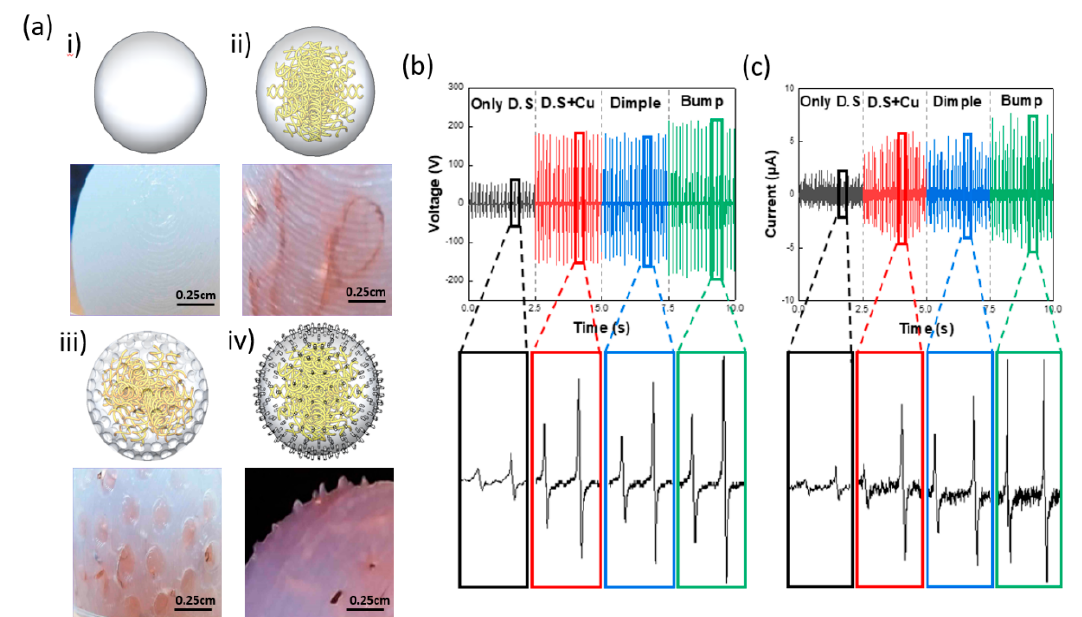
Figure 4. Changes in the output values according to the shape of the silicone rubber ball. ( a ) Pictorial representation and photographs of silicone rubber ball shapes: (i) the modeled shape and a 4× magnification photograph of the silicone rubber surface of the ball made only of D.S., (ii) the modeled shape and a 4× magnification photograph of the silicone rubber surface of the ball made by mixing copper wool into the silicone rubber ball interior, (iii) the modeled shape and a 4× magnification photograph of the silicone rubber surface of the ball made by adding dimple shapes to the silicone rubber ball surface to change the contact area, and (iv) the modeled shape and a 4× magnification photograph of the silicone rubber surface of the ball made by adding bump-shaped wires to the surface of the silicon rubber ball to change the contact area. ( b,c ) Plots showing the voltage and current according to differences in the ball shape.